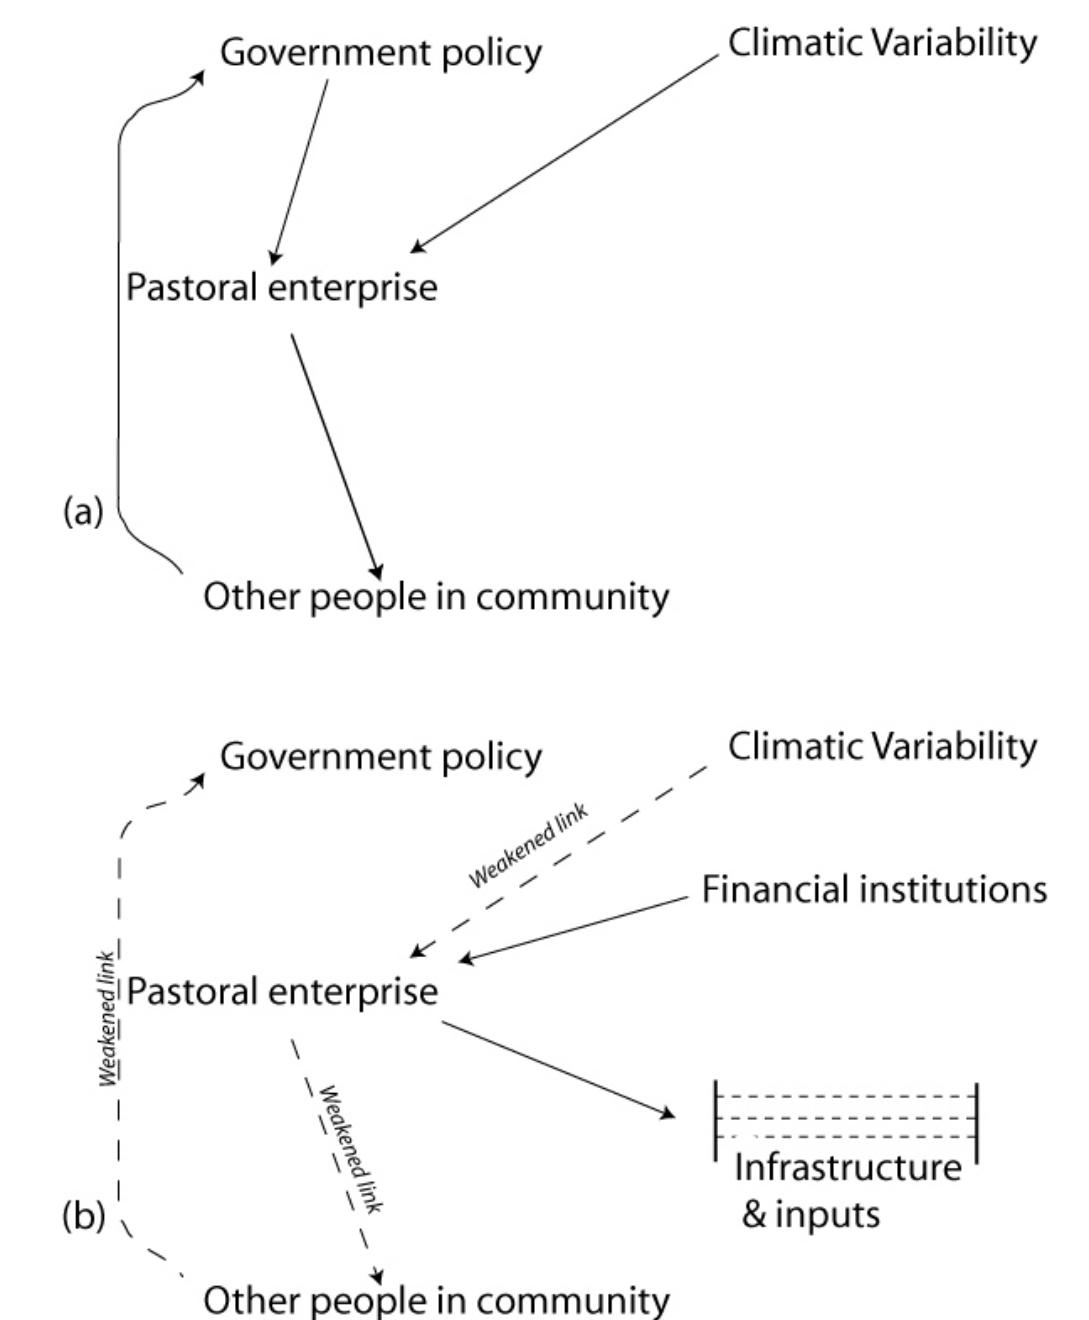
Fig. 5. Changes in a pastoral enterprise’s identity in response to 1960-1970 stress. (a) shows a "pre- release" enterprise with strong links to government, variability, and community. (b) shows the enterprise "post-release" with reduced links to government, community, and variability, and stronger links to financial institutions and the infrastructure needed for intensified